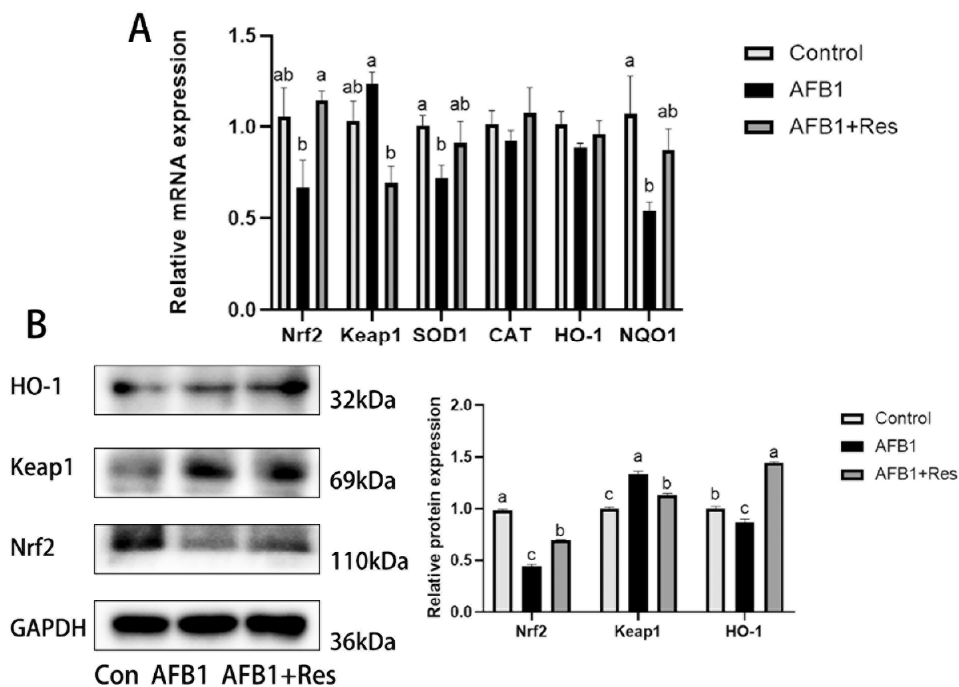
Figure 6. Effect of Res on Nrf2 signaling pathway in duck liver exposed to AFB1. ( A ): mRNA levels of the related genes of Nrf2 signaling pathway. ( B ): protein levels of the related genes of Nrf2 signaling pathway. Values are represented as the mean ± SEM ( n = 6). a–c Mean values with same superscript letters or no letters within a row were of no significant difference ( p > 0.05), those with different superscript letters were of significant or extremely significant difference ( p < 0.05).